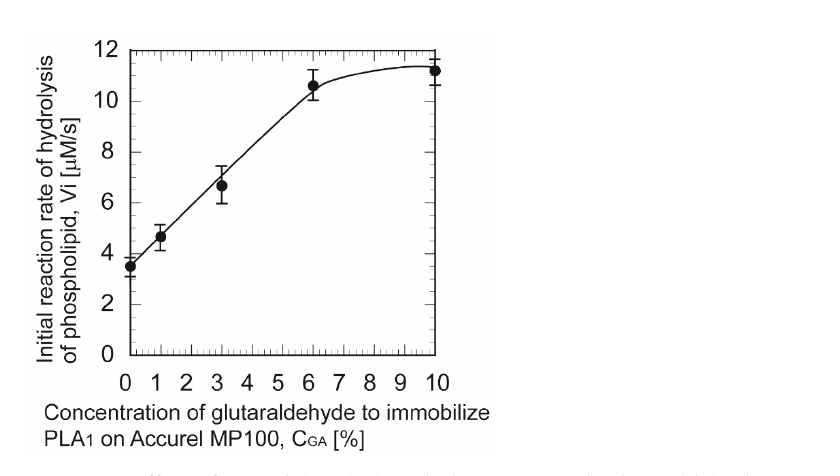
Figure 6. Effect of immobilized phospholipase A 1 with glutaraldehyde treatment on the initial reaction rate.